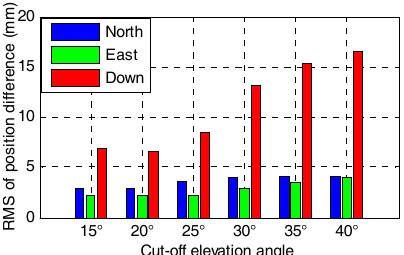
Figure 13. RMS of positioning difference of RTK for GPS/BDS with elevation cut-off angles of 15, 20, 25, 30, 35 and 40°.